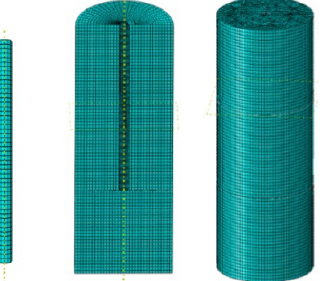
Figure 3. Mesh division of pile–soil model.